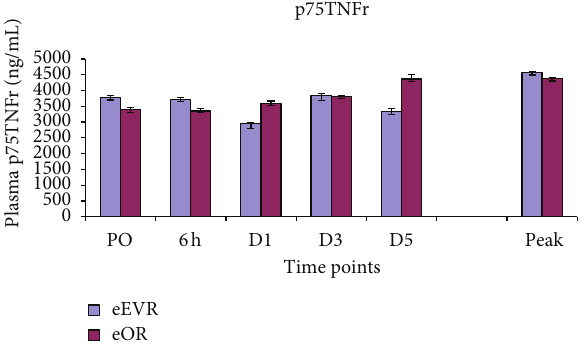
Figure 2: Plasma p75TNFr concentrations expressed as median and interquartile range. At D5 𝑃 = 0.04 eEVR versus eOR; D5 versus PO in eOR 𝑃 = 0.02 .